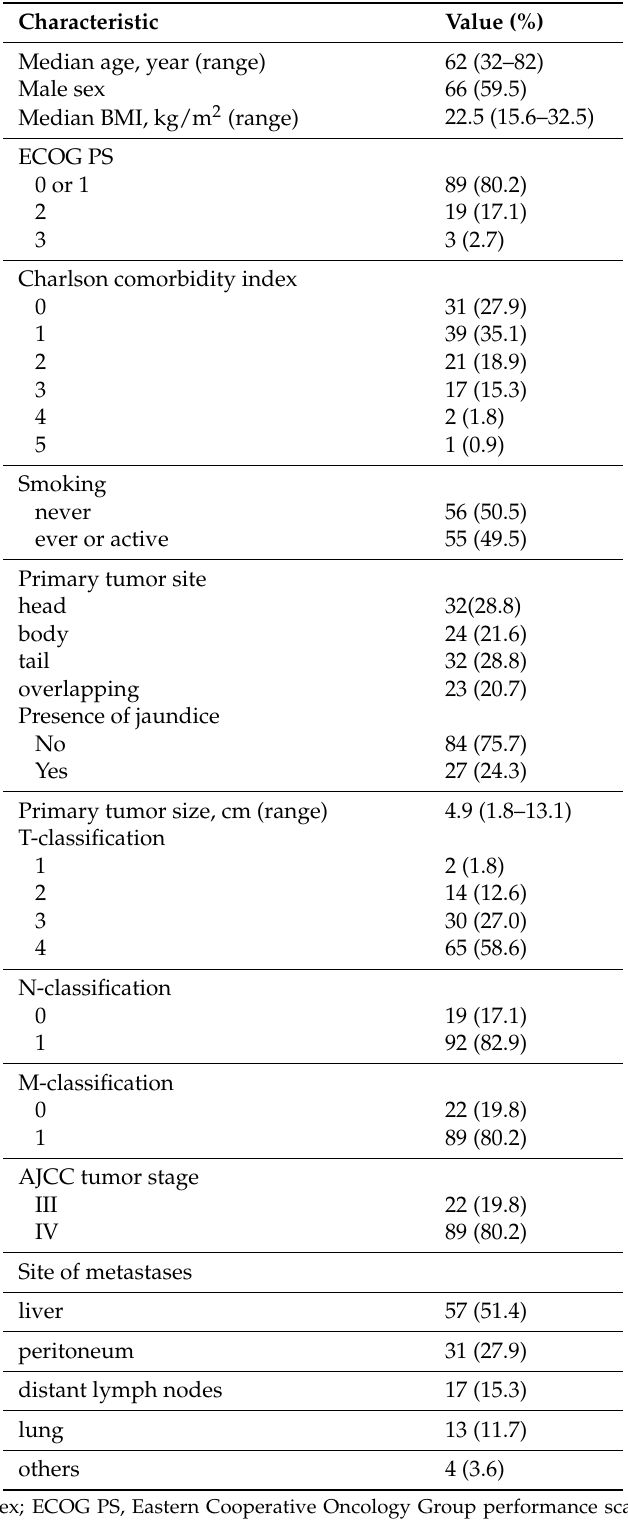
Table 1. Patient characteristics ( n =